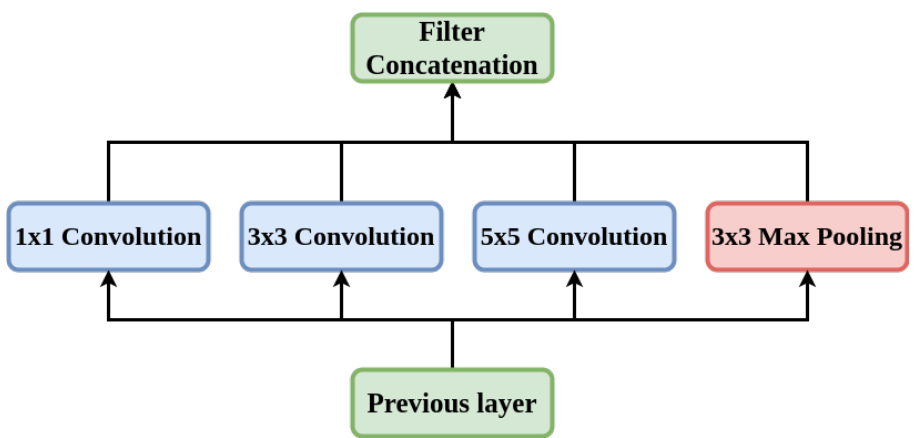
Figure 6. Architecture of Inception-V3